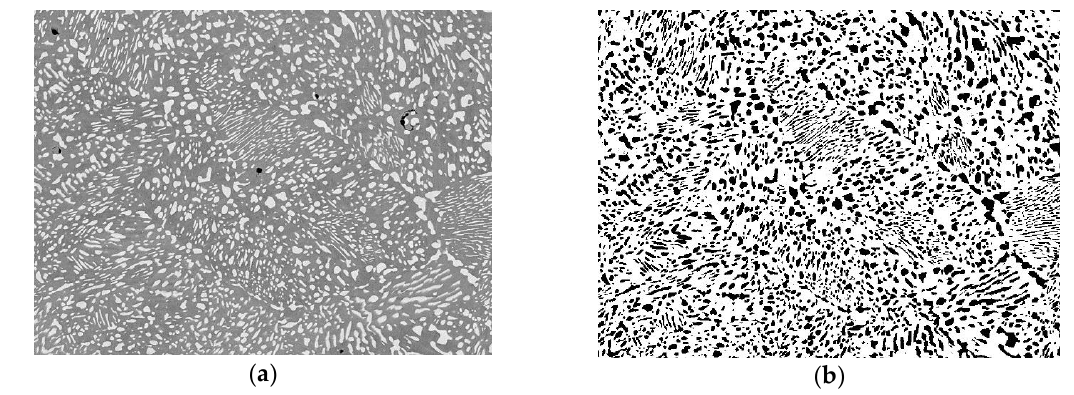
Figure 1. Binarization of SEM micrograph for digital image analysis: ( a ) SEM grey level pixel image of σ phase, in the Co matrix; ( b ) binary image where the σ phase appears black and the Co matrix white.